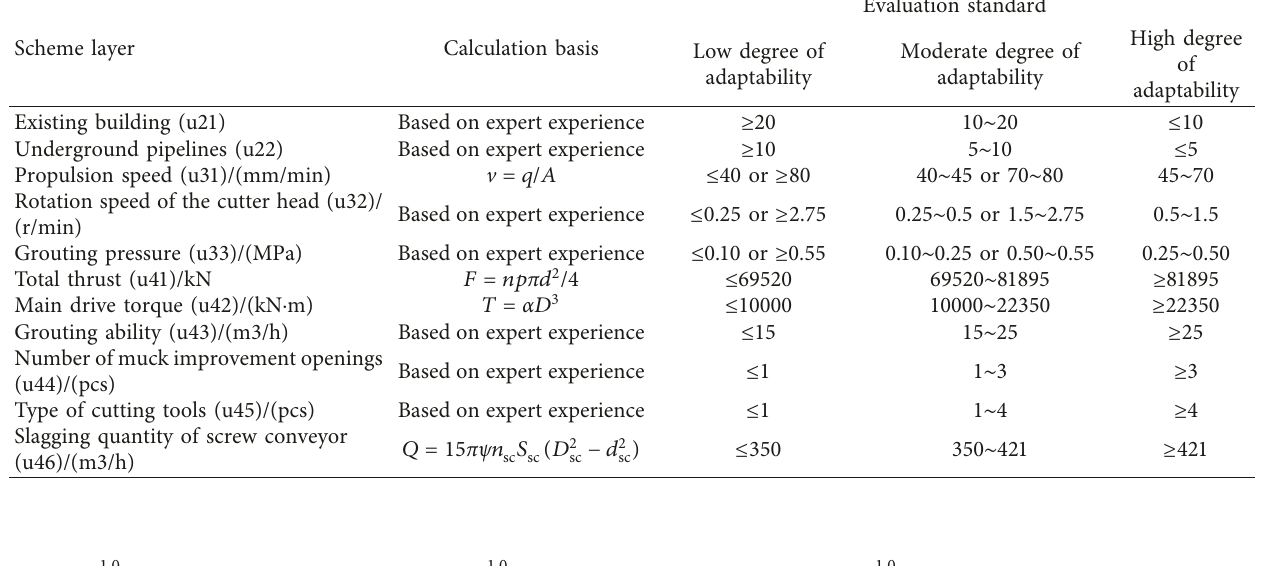
Table 9: Evaluation standard for the evaluation